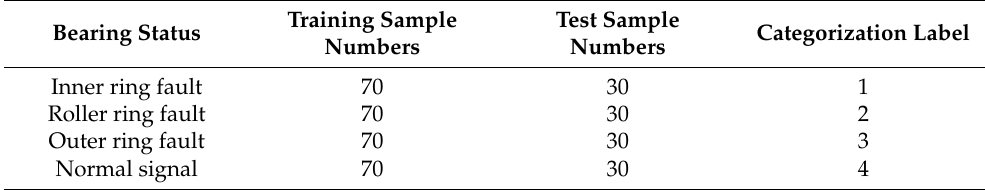
Table 1. Description of bearing pattern recognition dataset.